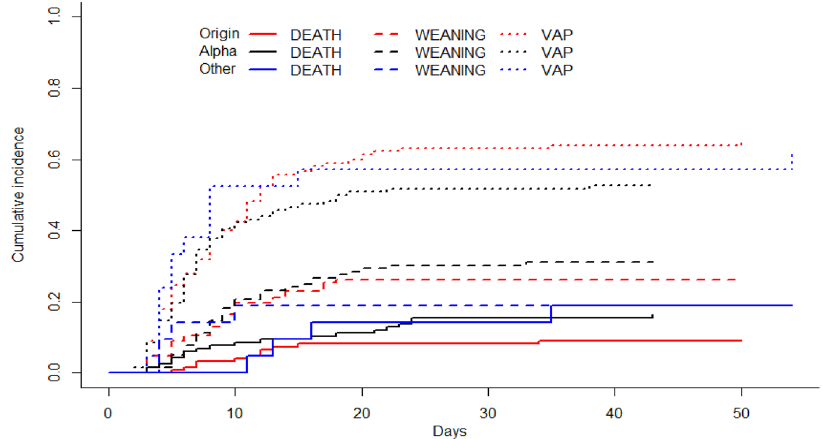
Figure1. Day-60 cumulative probability of ventilator-associated pneumonia (VAP) in patients infected with the variant of origin (red lines), variant α (black lines) or other variants (blue lines). Cumulative incidence estimated using the Kalbfleish and Prentice method considering time from intubation to VAP (dotted line), to death (continuous line) and to weaning (dashed line).